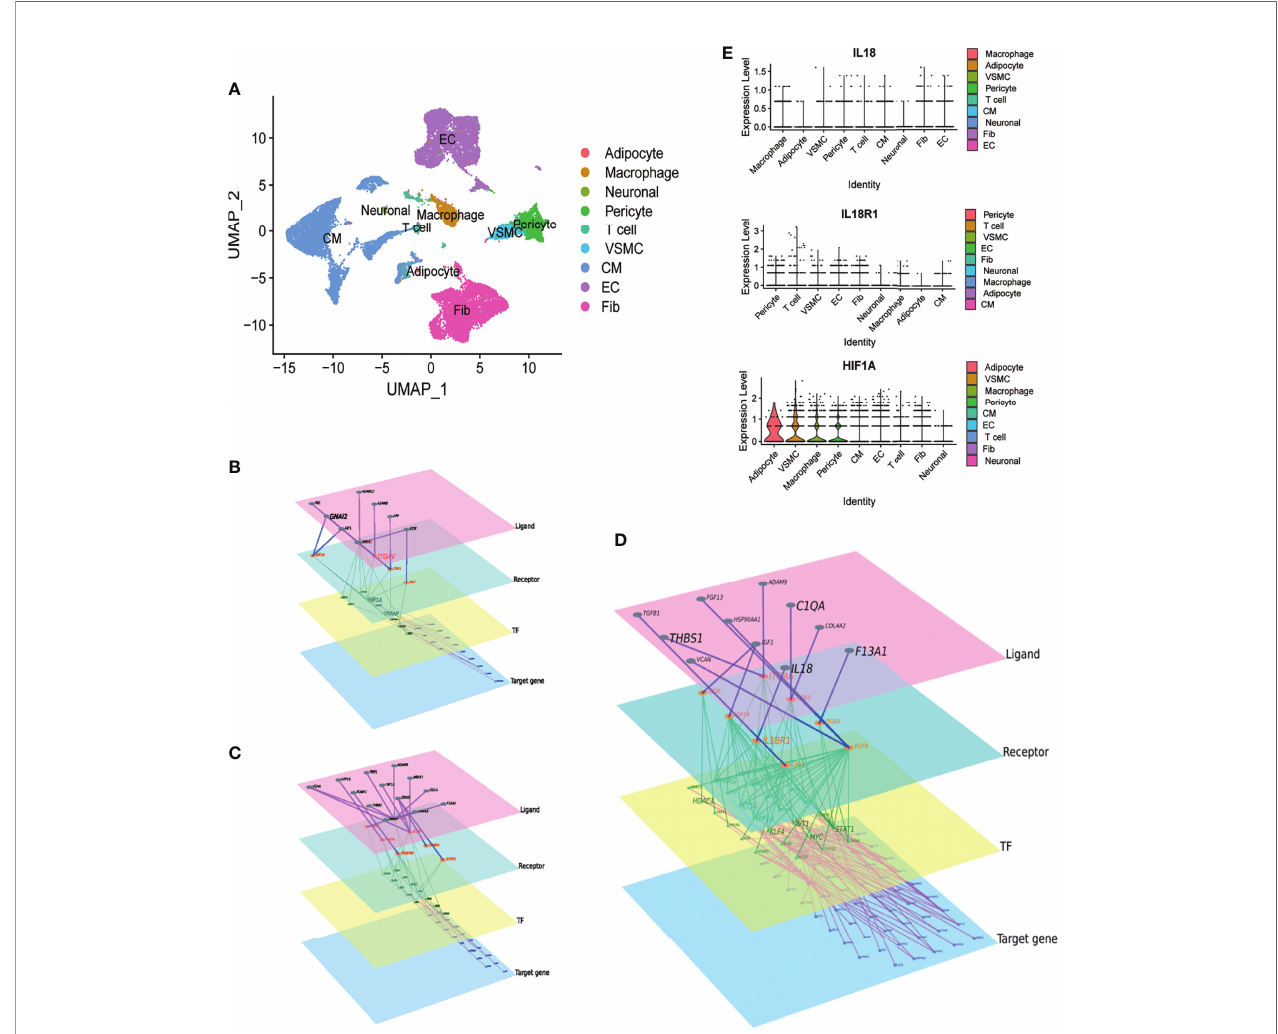
FIGURE 3 | Macrophage-derived IL18 regulates HIF-1 signaling through IL18R1. A.UMAP scatter plot of cell types in the heart of COVID-19 patients derived from GSE171668. (A) total of 29,472 cells were included in 9 types. (B) The molecular regulatory network between macrophages and cardiomyocytes. (C) The molecular regulatory network between macrophages and vascular smooth muscle cells. (D) The molecular regulatory network between macrophages and endothelial cells. There are four layers of ligand, receptor, TF and Target genes in the networks, which were marked by different colors. Up-regulated genes in aneurysm and atherosclerosis were marked in (B – D) . (E) Expression distribution of IL18, IL18R1 and HIF-1A in different cell